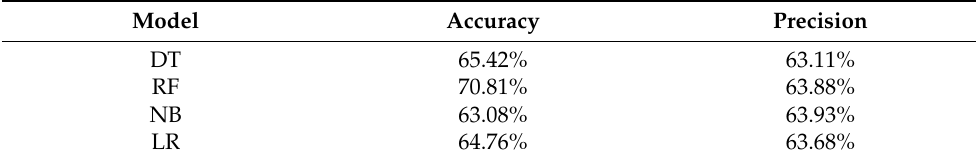
Table 3. Model s’ performance in the traditional approach using RapidMiner. Table 3. Models’ performance in the traditional approach using